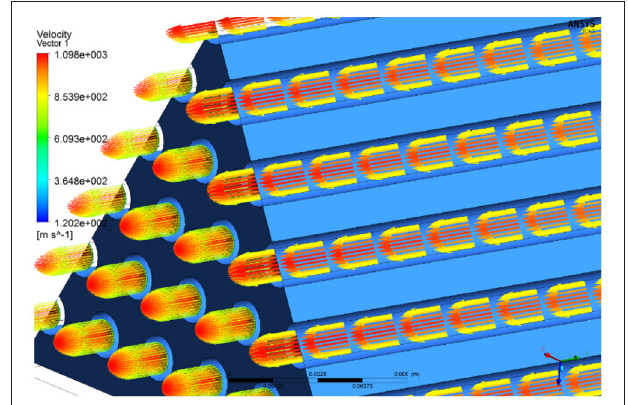
FIGURE 15 | Coolant velocity distribution of average channel.